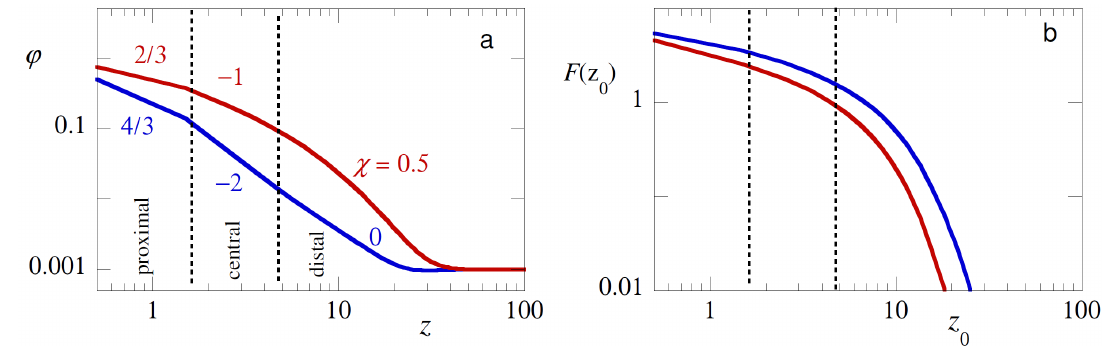
Figure 6. ( a ) The volume fraction profile ϕ B ( z ) in double logarithmic coordinates, for homopolymers = 10 − 3 , with an adsorption strength with length N B = 1000, adsorbing from dilute solution ϕ b B χ SB = − 6. The proximal, central and distal regions are indicated. The local slopes ∂ log ϕ ( z ) / ∂ log z for the proximal and central regions are indicated. Red curve χ = 0.5, Blue curve χ = 0. ( b ) The corresponding F ( z 0 )